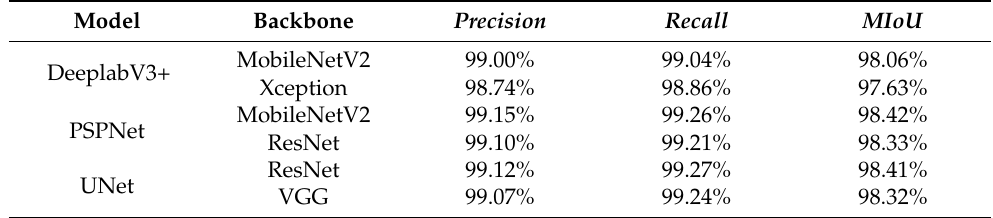
Figure 6. The prediction examples of DeeplabV3+ (MobileNetV2), PSPNet (MobileNetV2) and UNet (VGG) for apple leaves: the leaf area with the blue circle has only the base truth with no predicted results, which is a false negative ( FN ), and the red circled leaf area only has the predicted result with no base fact, which is false positive ( FP ). Table 2. Performance comparison of models in apple leaf identification.